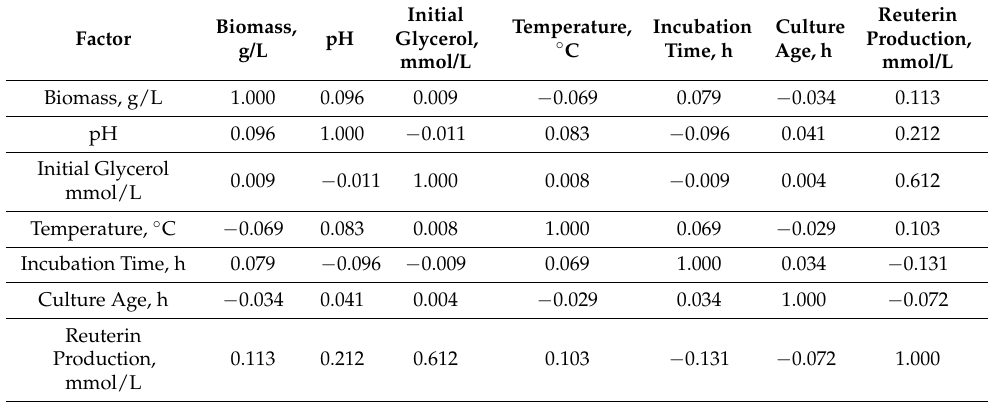
Table 1. Correlation Matrix ( p < 0.05) for factors affecting reuterin